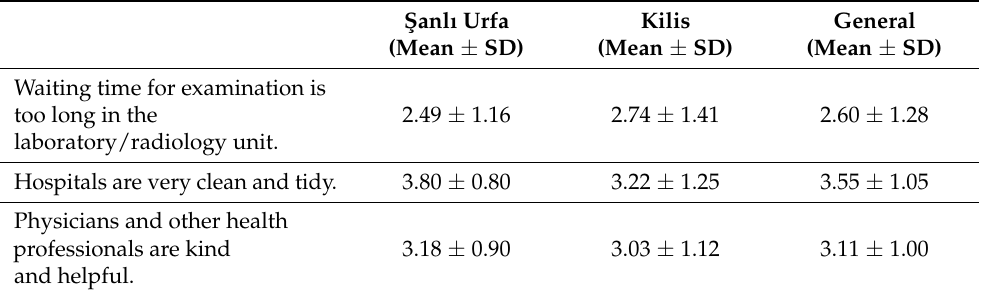
Table 3. The refugees’ views on healthcare